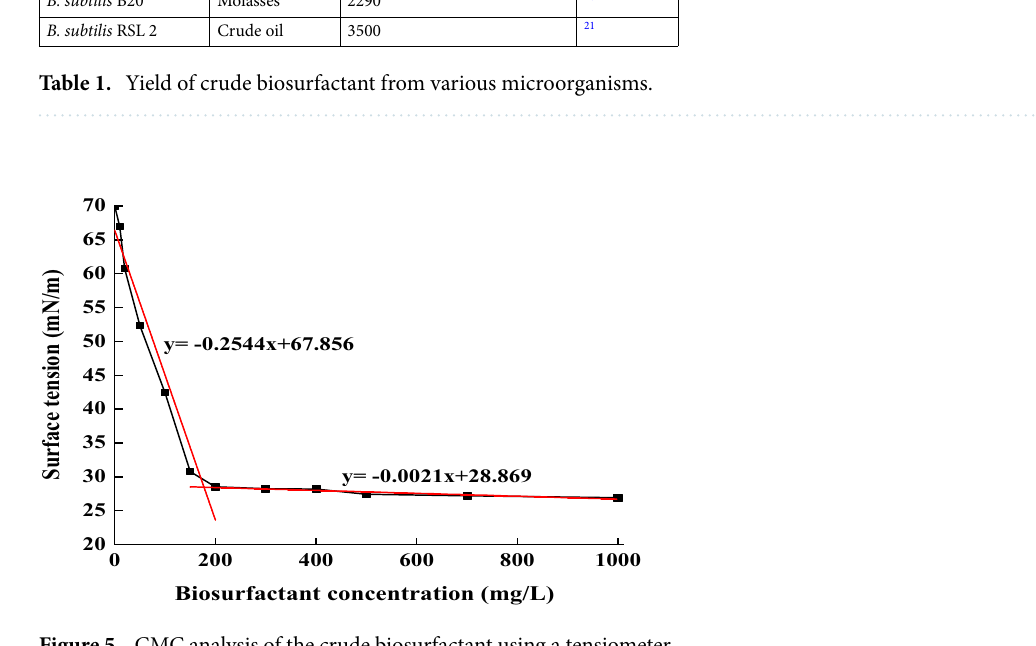
Figure 5. CMC analysis of the crude biosurfactant using a